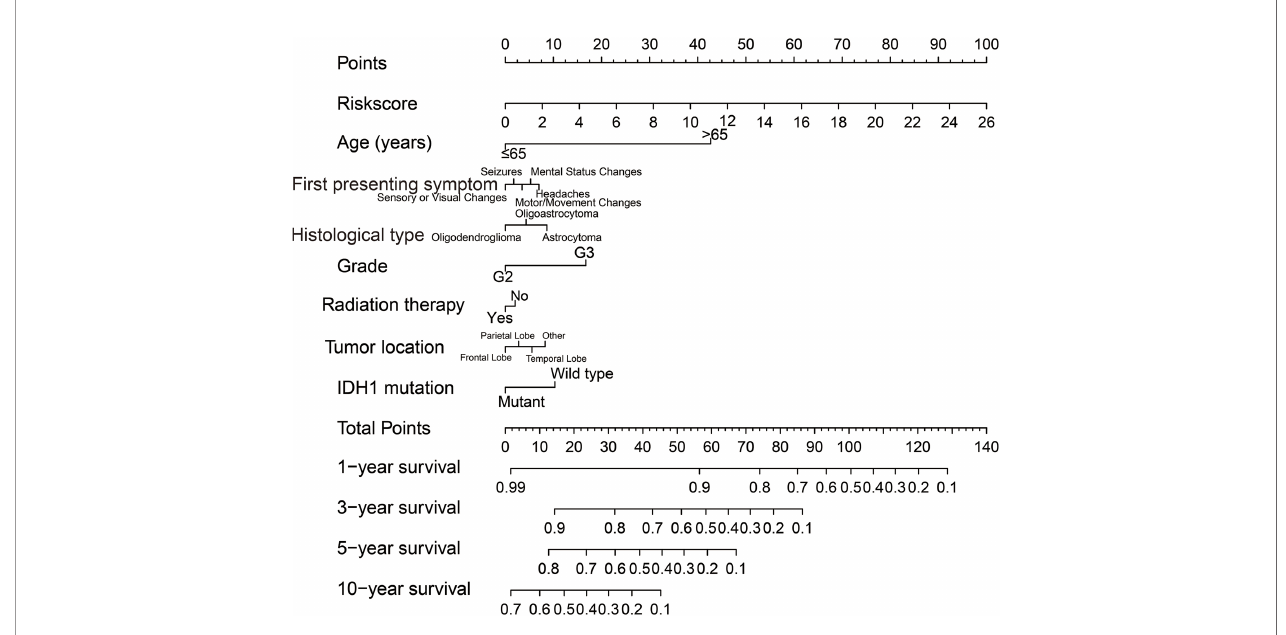
FIGURE 5 | A nomogram constructed in TCGA LGG cohort based on risk score and clinical parameters.